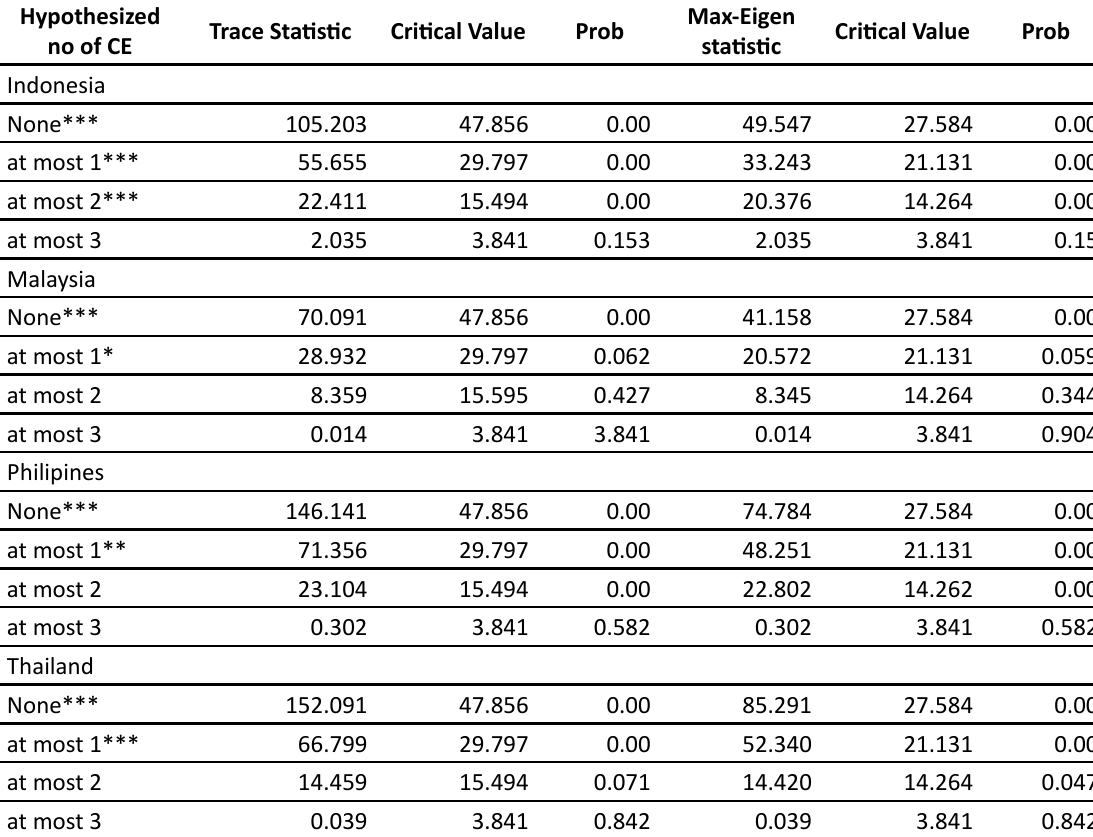
Table 3: Johansen Cointegration Test